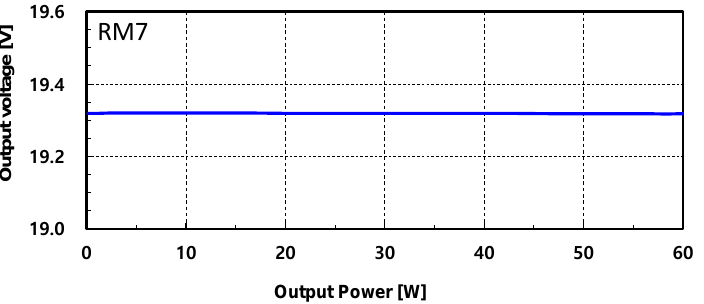
Figure 24. Output voltage characteristics versus load current of a QR flyback converter with SDAS at an input voltage of 310 V.